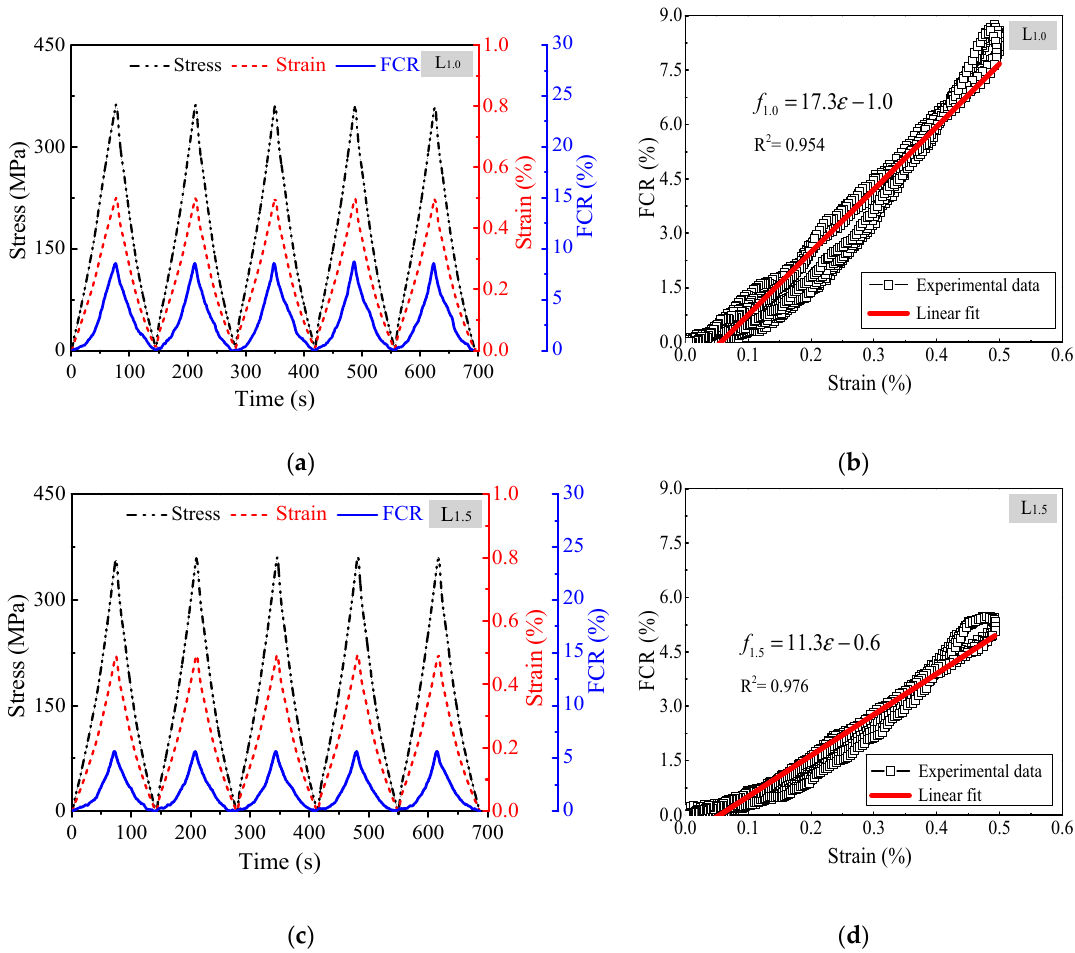
Figure 10. Strain monitoring of CNF/GFRP laminates under constant amplitude cyclic tensile loading: ( a ) FCR, strain and stress vs. time for L 1.0 ; ( b ) FCR vs. strain for L 1.0 ; ( c ) FCR, strain and stress vs. time for L 1.5 ; ( d ) FCR vs. strain for L 1.5